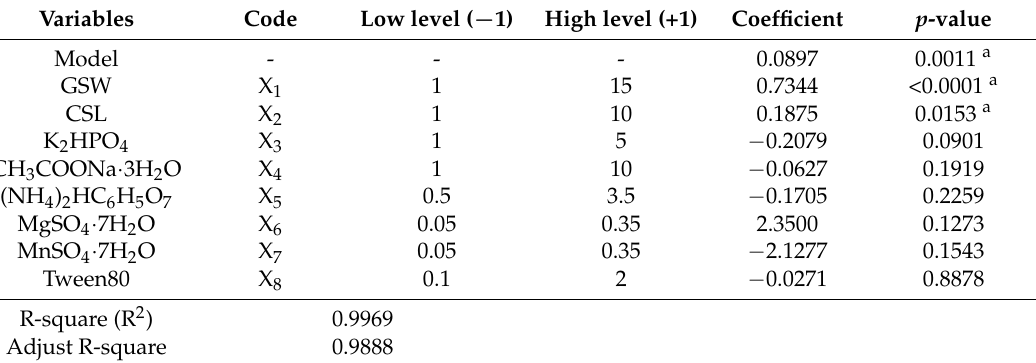
Table 2. The Plackett–Burman design for screening significant variables in lactic acid production at 37 °C under static conditions for 18 hr.